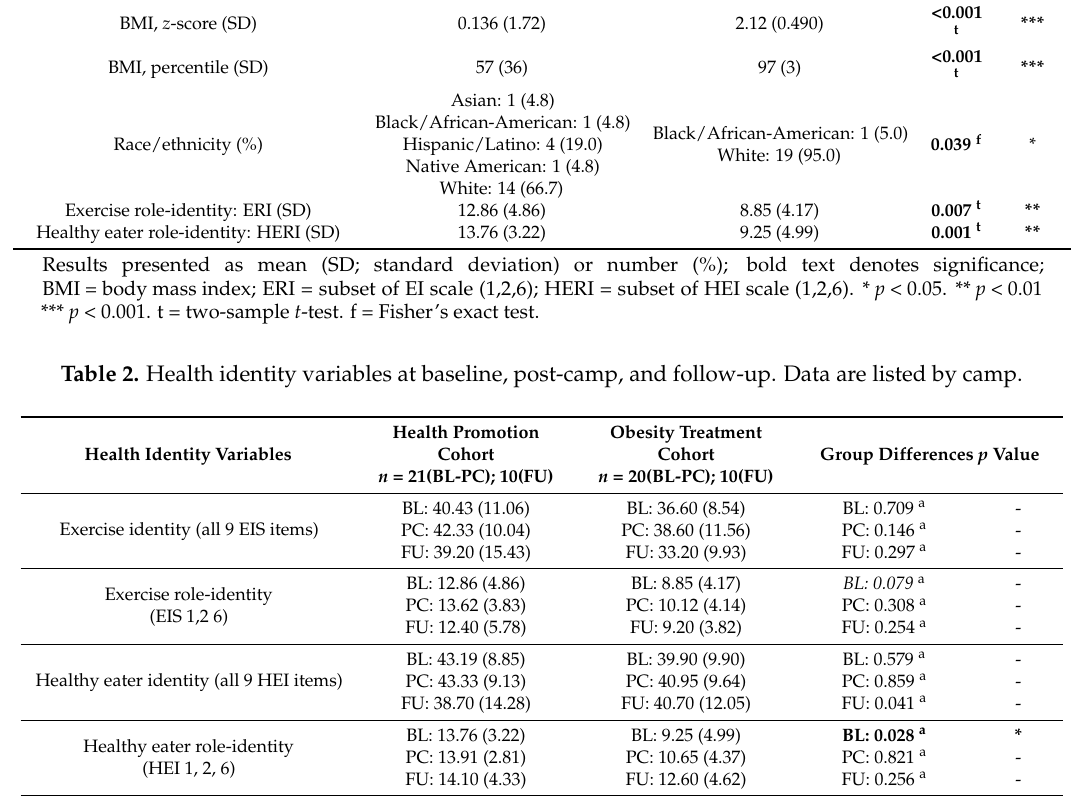
Table 1. Characteristics of adolescent girls at baseline, health promotion cohort (Colorado, CO camp), and obesity treatment cohort (Wisconsin, WI camp).